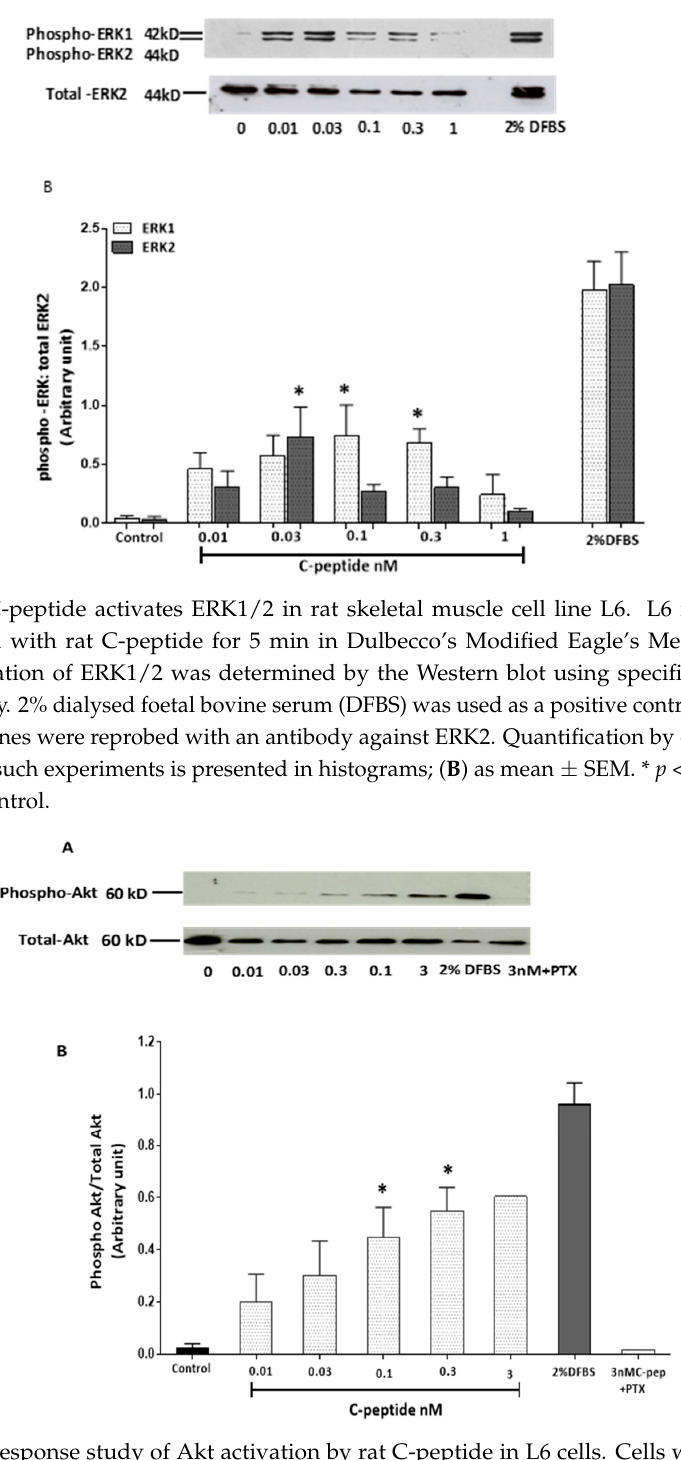
Figure 2. Dose response study of Akt activation by rat C-peptide in L6 cells. Cells were stimulated with rat C-peptide for 5 min in DMEM. Pertussis toxin (PTX) denotes the effect of co-incubation with 100 ng/mL Pertussis toxin. Phosphorylation of Akt was determined by the Western blot ( A ) using specific anti-phospho-Akt antibody. DFBS (2%) was used as a positive control. As a loading control, membranes were reprobed with antibody against total Akt; ( B ) quantification by densitometry of data from three such experiments: mean ± SEM * p < 0.05 versus the unstimulated